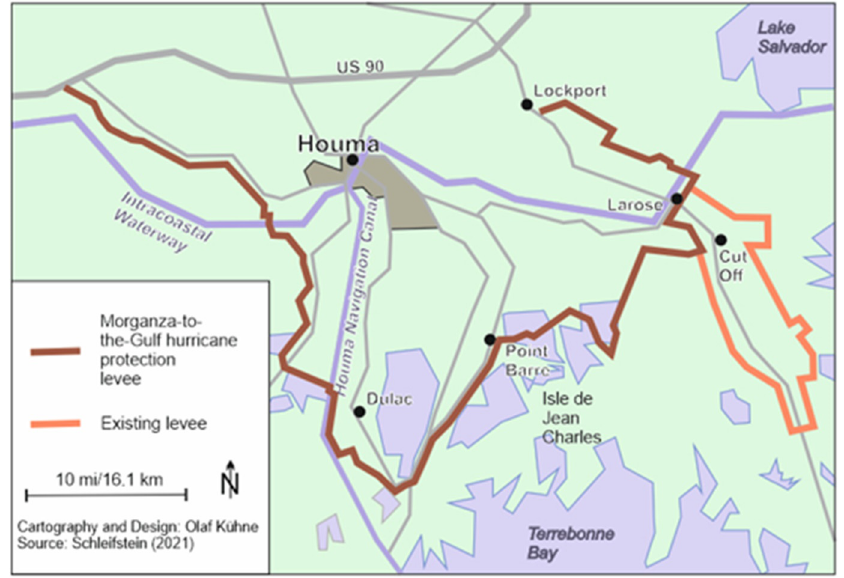
Figure 5. Map of the Morganza to the Gulf Risk Reduction System, highlighting that not all inhabited areas are located within the levees protection (own representation based on [62], as in [54]).